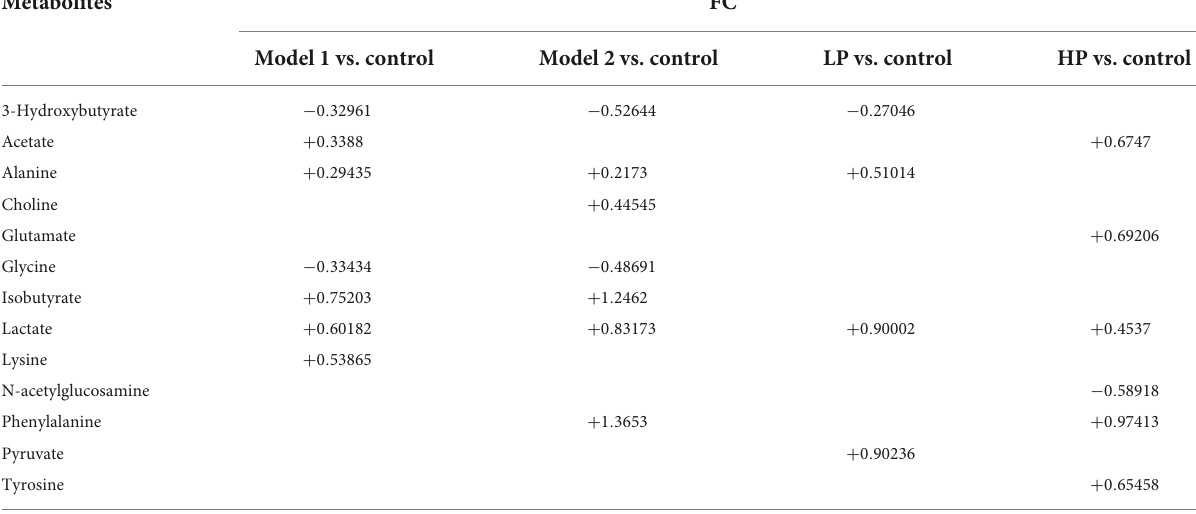
TABLE 2 Correlation coefficients of serum differential metabolites between different paired comparison groups. Metabolites FC Model 1 vs.